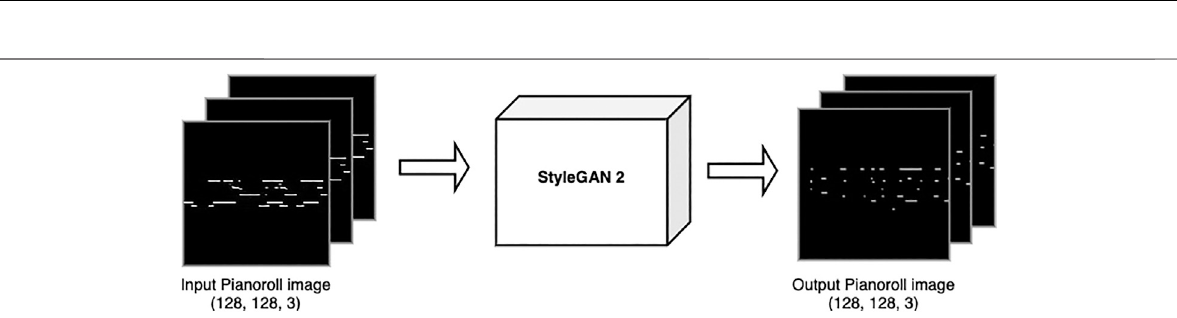
Frontiers in Robotics and AI |